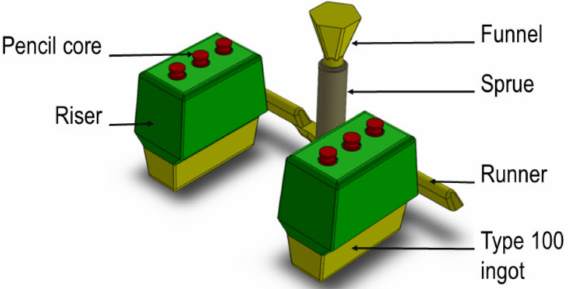
Figure 2. Casting device. Table 1. G20Mn5 chemical composition